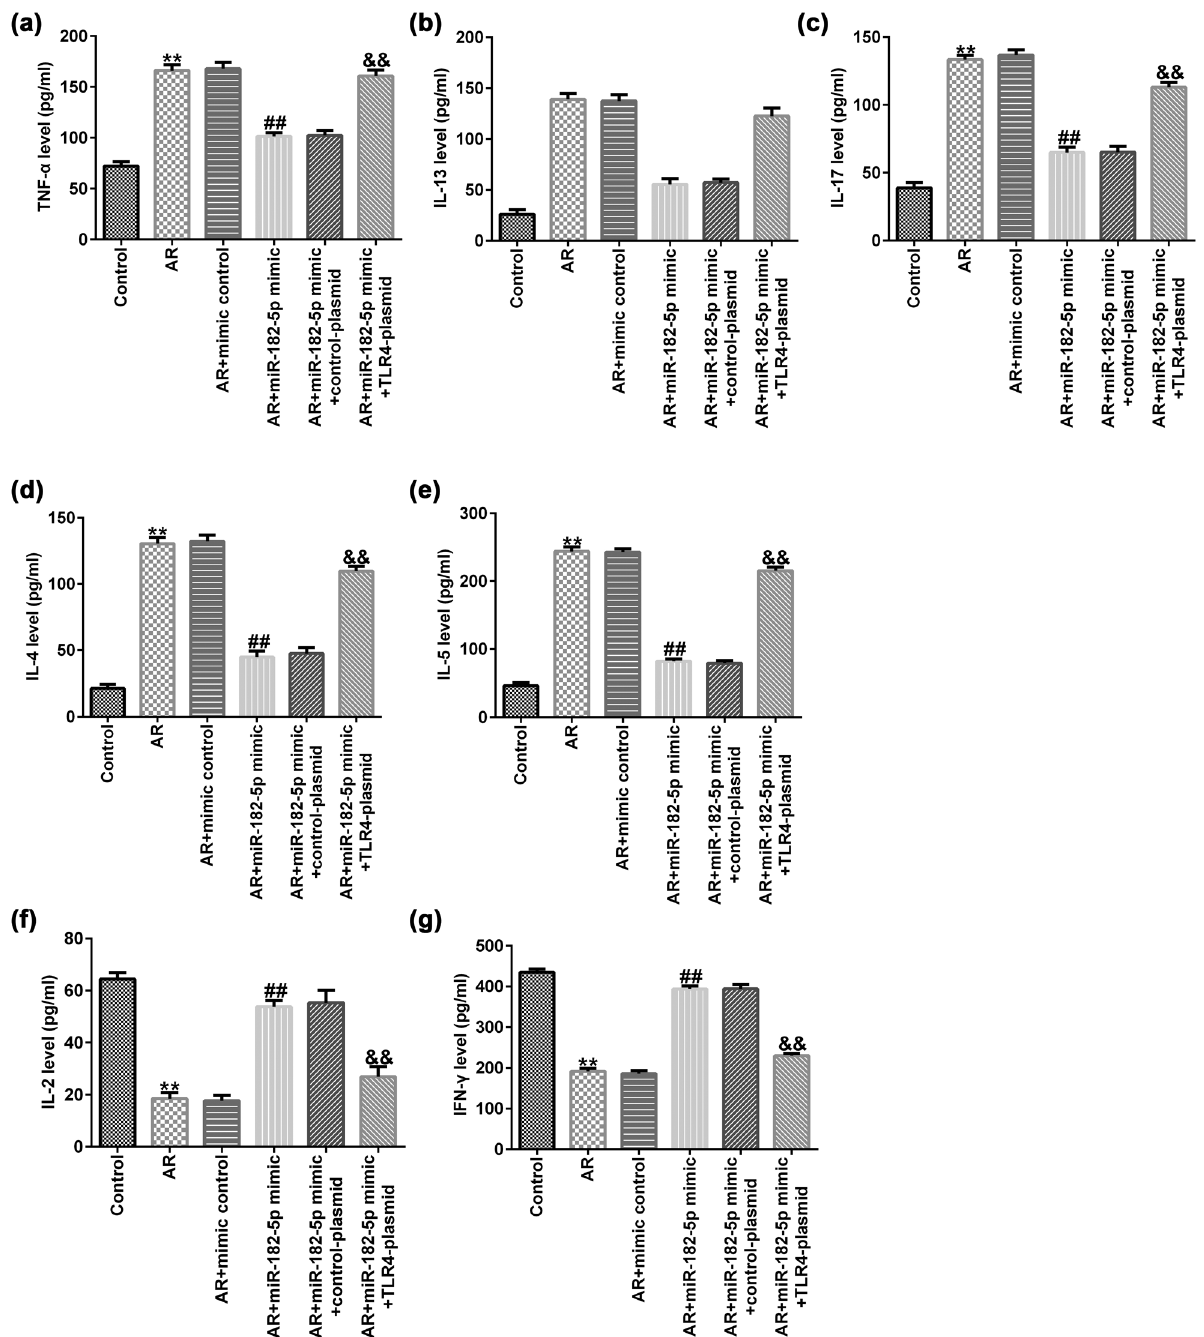
Figure 6: TLR4 reversed the e ff ect of miR - 182 - 5p on the expression of in fl ammatory cytokines in AR mice ( n = 3 ) . ( a – g ) The expression levels of TNF - α , IL - 13, IL - 17, IL - 4, IL - 5, IL - 2 and IFN - γ in the serum samples from di ff erent groups. TLR4, toll - like receptor 4; AR, allergic rhinitis; TNF - α , tumor necrosis factor - α ; IL13, interleukin 13; IL - 17, interleukin 17; IL - 4, interleukin 4; IL - 5, interleukin 5; IL - 2, interleukin